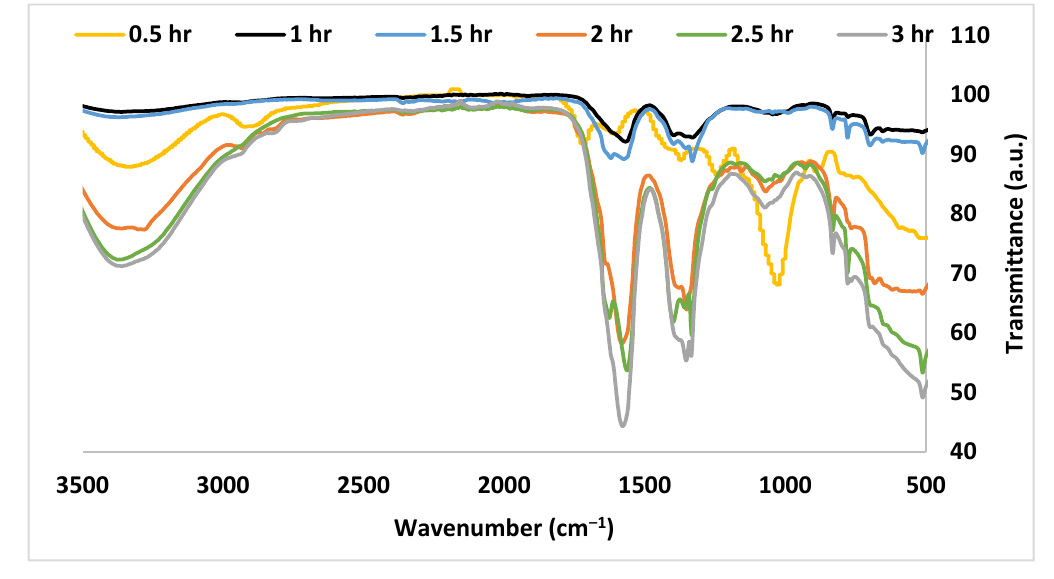
Figure 4 . FTIR results for CDs generated at 180 °C and all residence times in top-down synthesis. Figure 4. FTIR results for CDs generated at 180 ◦ C and all residence times in top-down synthesis. Samples were freeze-dried and tested as solids. Samples were freeze-dried and tested as solids.